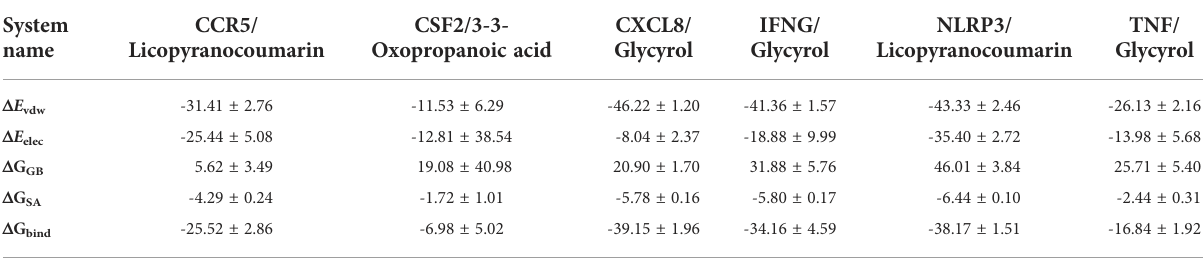
TABLE 2 Binding free energies and energy components predicted by MM/GBSA